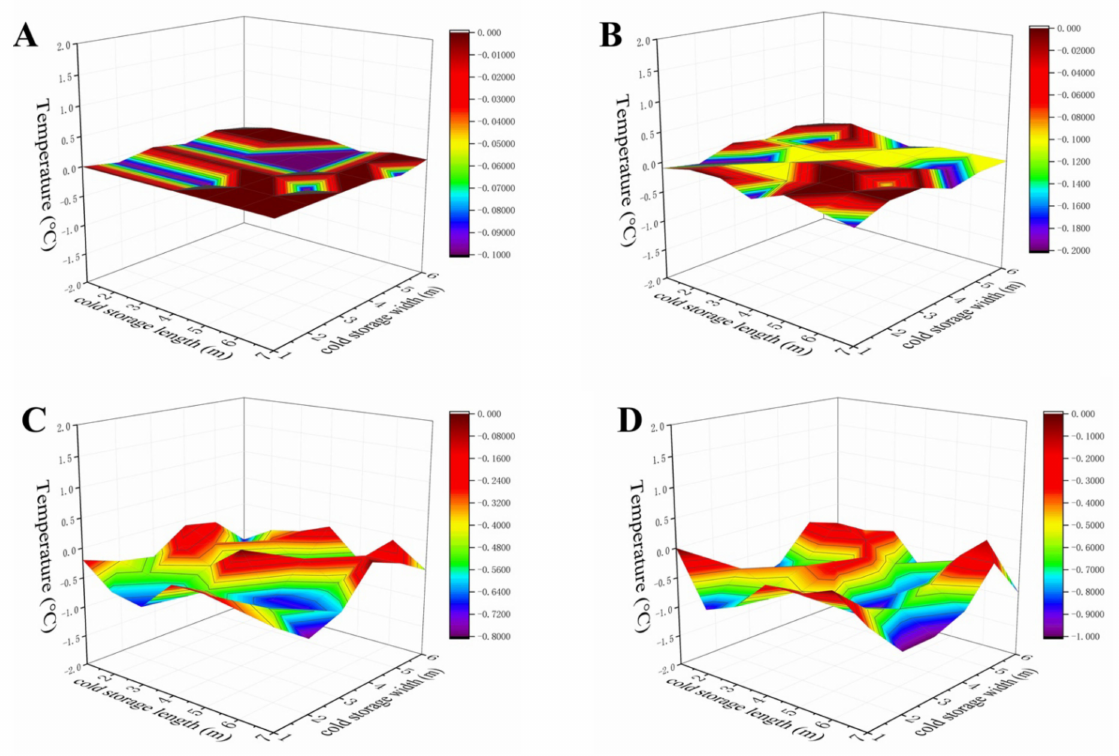
Figure 2. Temperature fluctuations at 0.5 ( A , C ) and 3.5 m ( B , D ) height in the improved ( A , C ) and the conventional ( B , D ) cold